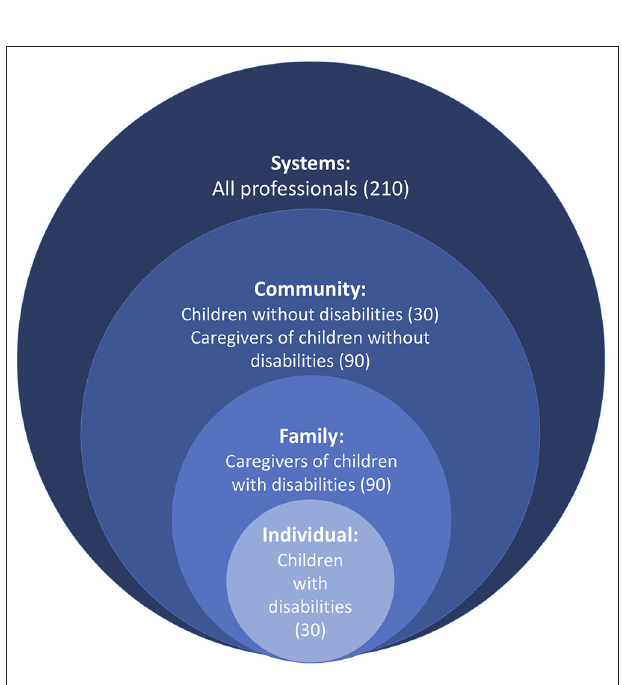
FIGURE 1 | Conceptual model connecting communication approaches and activities to discrimination.